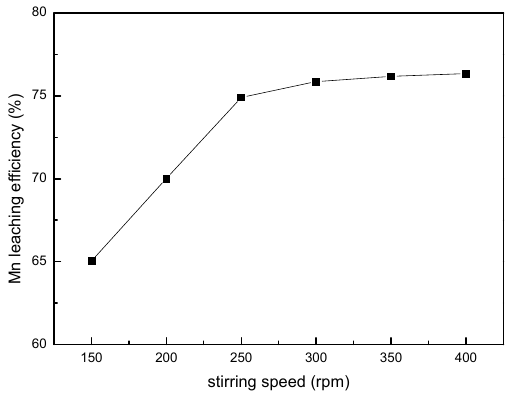
Figure 2. The effect of the stirring speed on the manganese leaching efficiency.